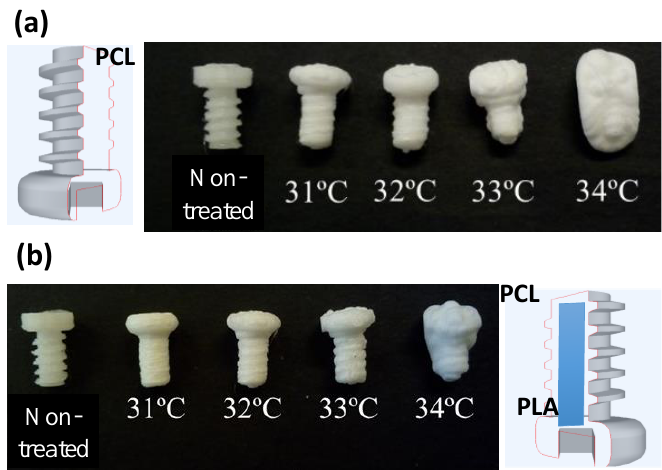
Figure 4. Optical photographs of the 3D-printed parts upon treatment in SCCO 2 at different temperatures. ( a ) Screws fabricated using PCL, ( b ) screws fabricated using a combination of PCL and PLA (protocol: 200 bar, 5 min).